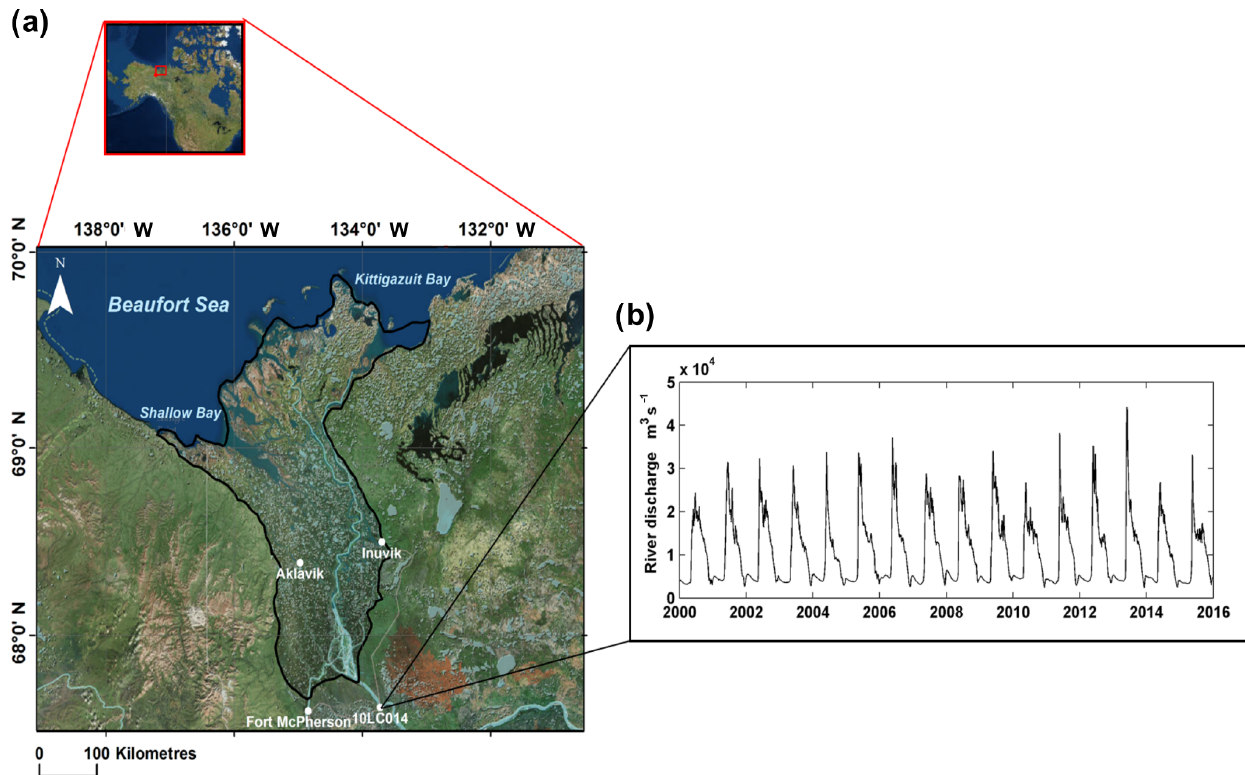
Figure 1. (a) Location of the Mackenzie Delta at the mouth of the Mackenzie River in the Northwest Territories of Canada. (b) River discharges of the Mackenzie River at 10LC014 station from 2000 to 2015 (133 ◦ W, 67 ◦ N), 30km upstream the Mackenzie Delta.